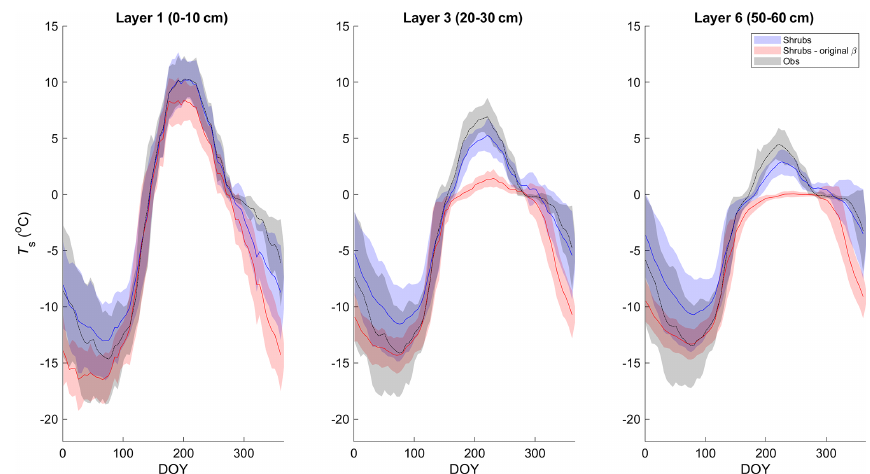
Figure 1. Mean 5d average soil temperature for layer 1 (0–10cm depth), 3 (20–30cm depth), and 6 (50–60cm depth) of the shrub simulations using the new (Merlin et al., 2011) and original β (Lee and Pielke, 1992) formulation compared to measurements at 5, 25, and 60cm depth, respectively, averaged over 2004–2017. Shaded areas show the standard deviation of the daily mean for 2004–2017.